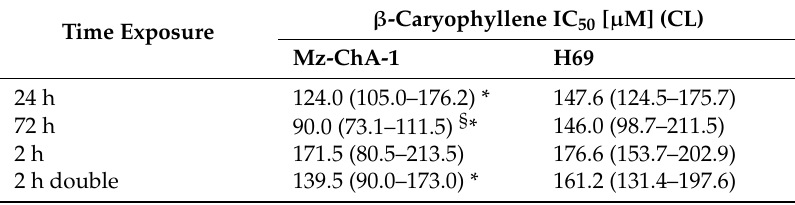
Table 1. IC 50 values of β -caryophyllene in cholangiocarcinoma Mz-ChA-1 cells and noncancerous H69 cholangiocytes under both long-term and metronomic schedules. In the last protocol, the cells were subjected to a short and / or double repeated exposure of 2 h to the test substance followed by a recovery time of 72 h. Data represent the mean ± SE (standard error) of at least two experiments in which each treatment was tested in triplicate ( n =